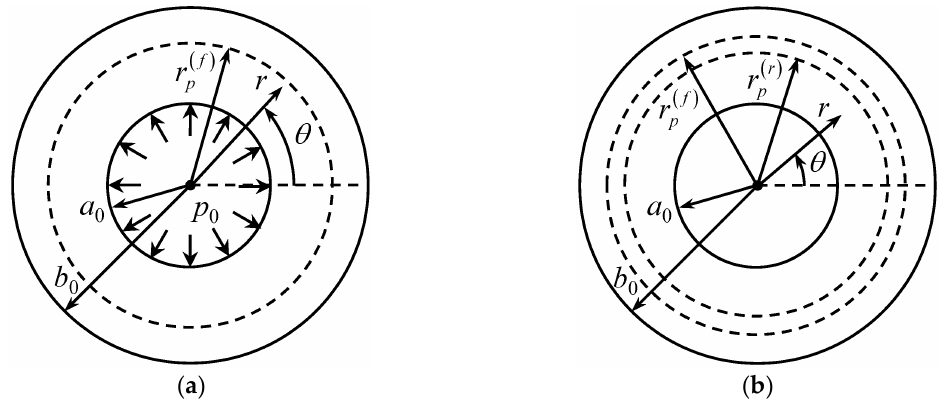
Figure 1. Illustration of the boundary value problem: ( a ) loading; ( b ) unloading.